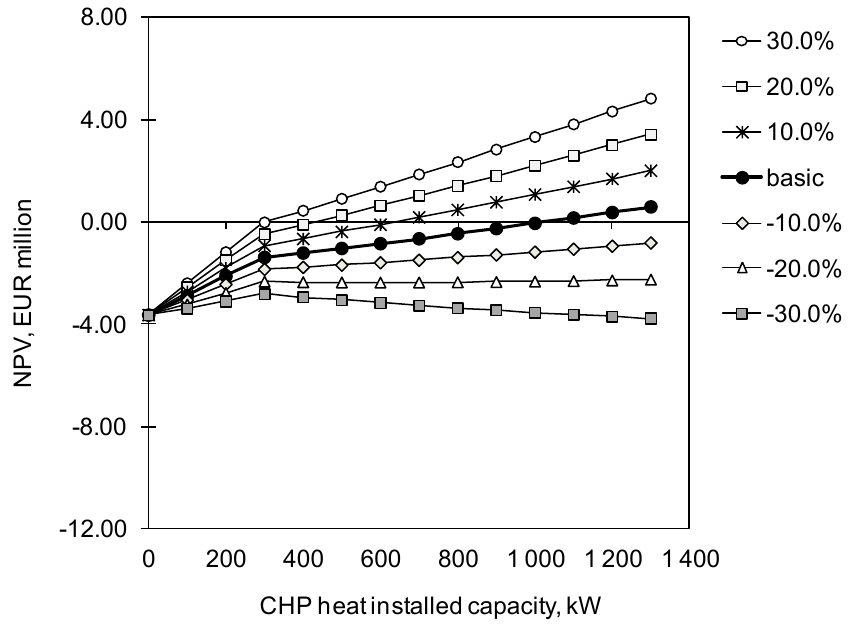
Figure 11. Sensitivity of the location of NPV(15) function maximum for varying electricity prices.